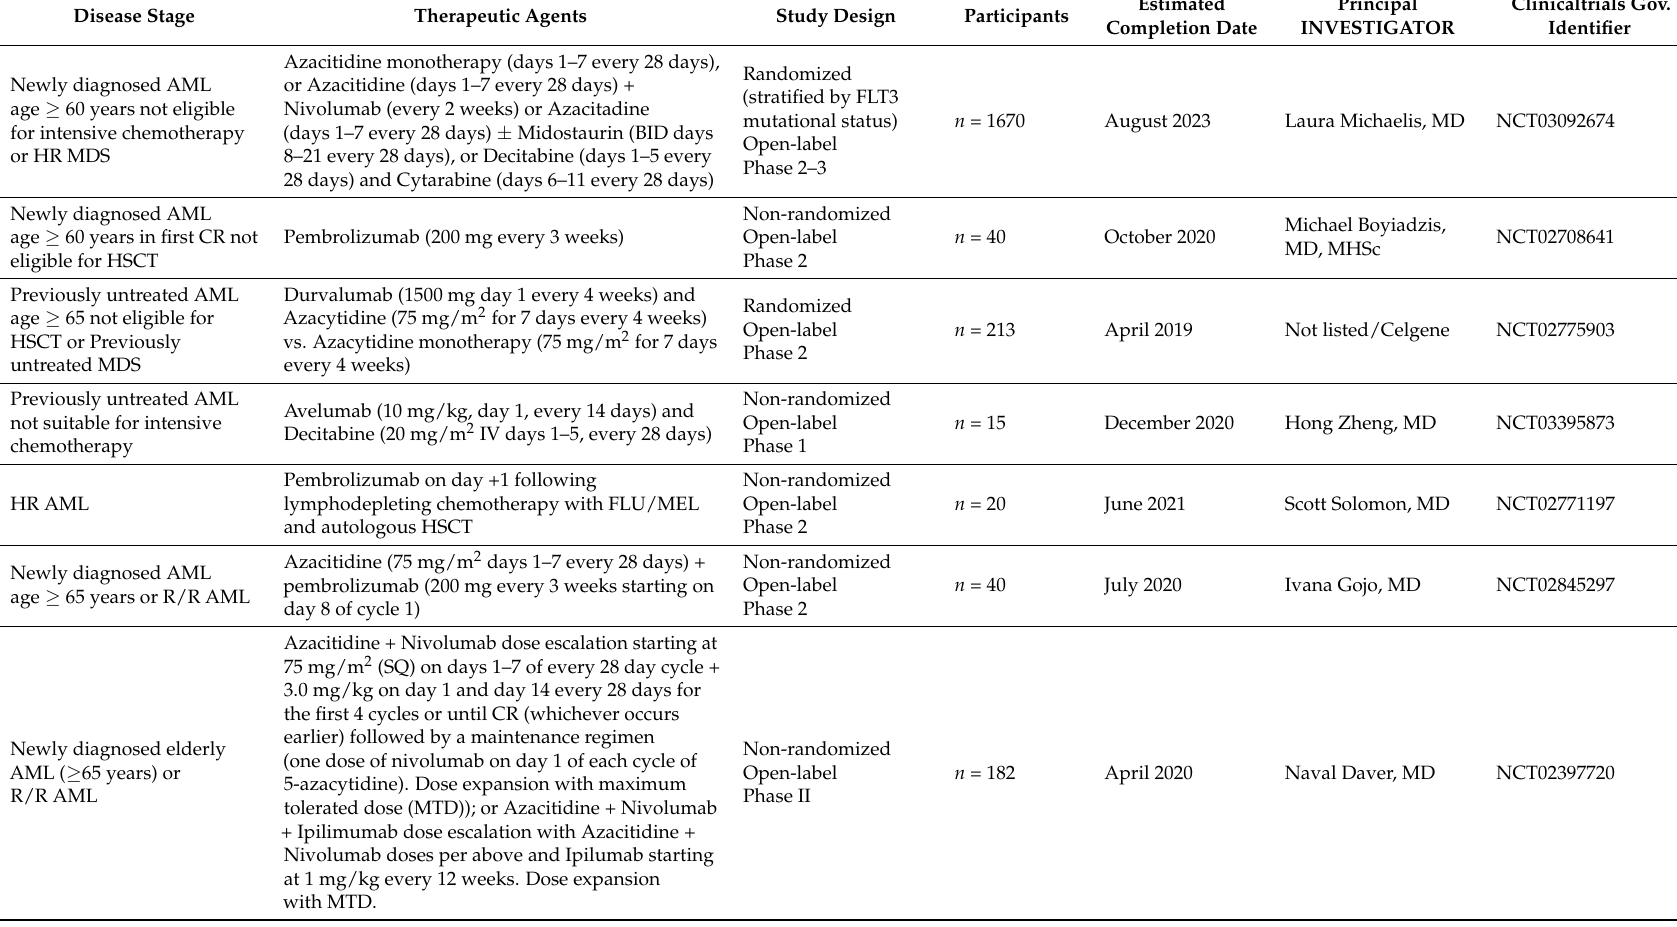
Table 1. Completed and ongoing clinical trials of ICB with anti-PD-1/PD-L1 antibodies in